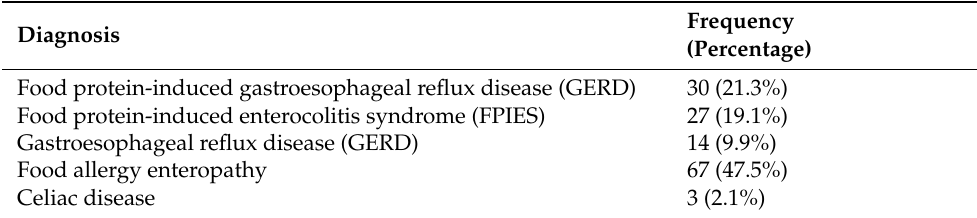
Table 2. Diagnoses in the clinical group ( N =